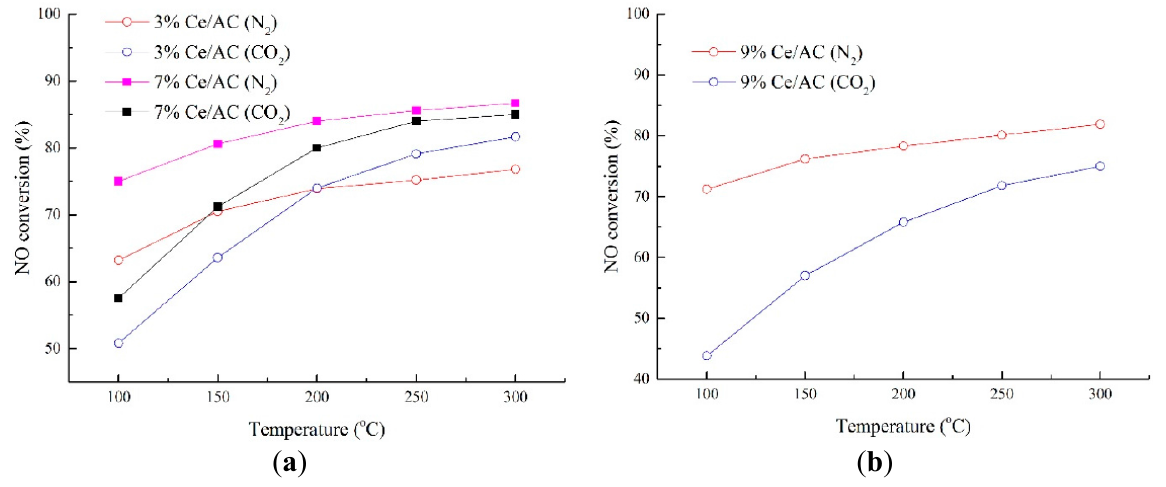
Figure 3. NH 3 -SCR using Ce/AC catalyst under CO 2 and N 2 atmosphere: ( a ) 3% Ce/AC and 7% Ce/AC; ( b ) 9% Ce/AC. Other conditions: 800 ppm NO; 800 ppm NH 3 ; 6% O 2 and space velocity 3408 h − 1 .